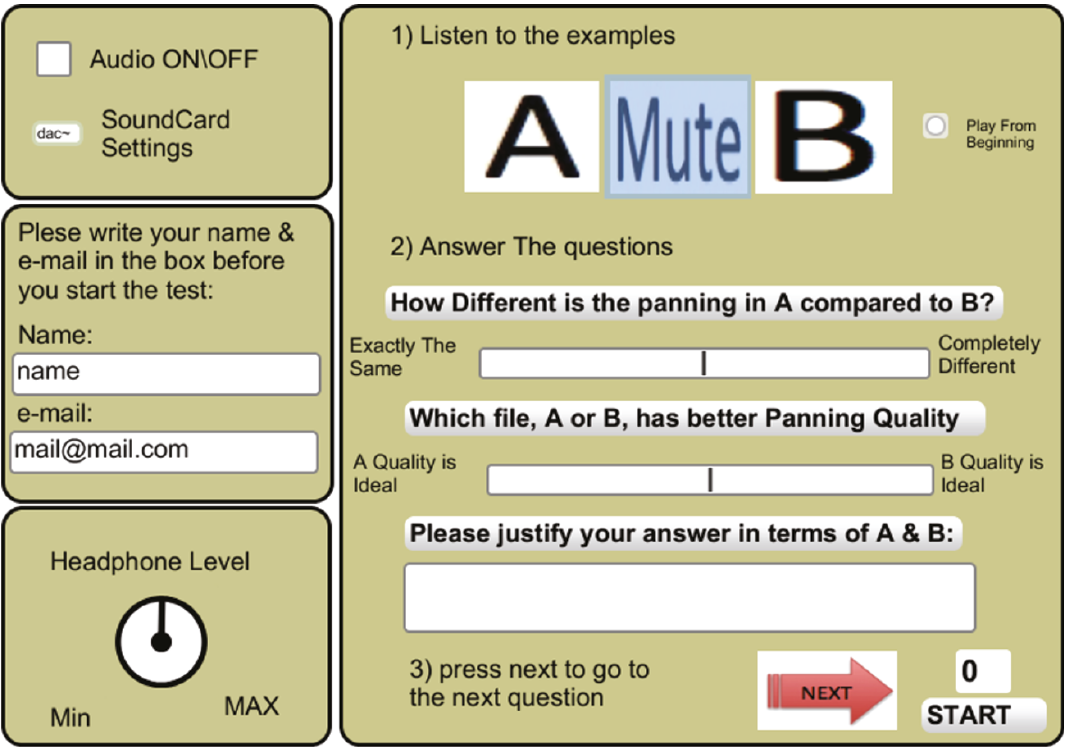
Figure 7: Double blind panning quality evaluation test interface.